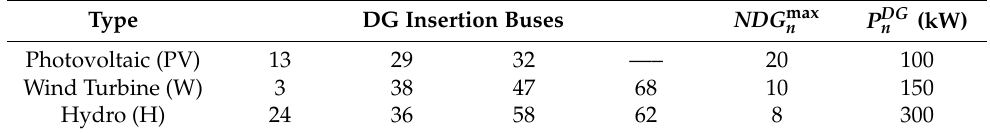
Table 1. Case study I: insertion buses, maximum number of DG modules and unity capacity.